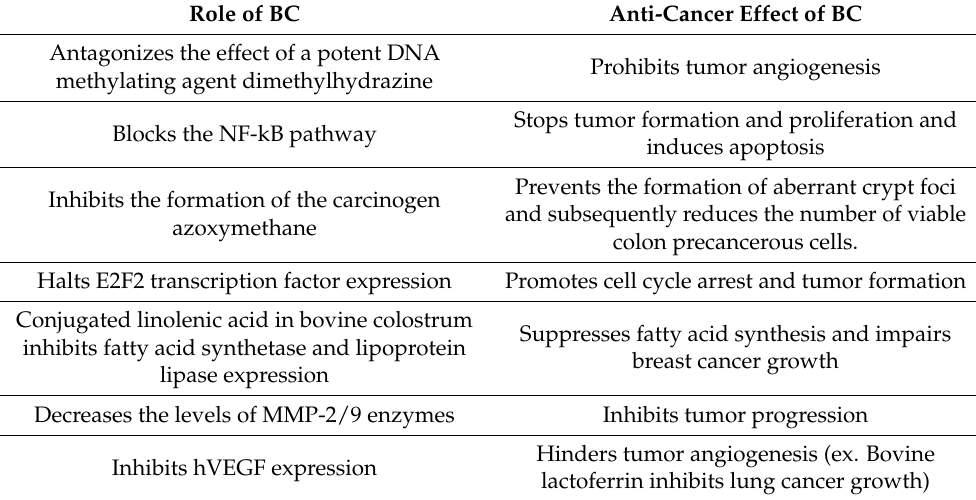
Table 4. The role of BC in prevention of tumor initiation, proliferation, and